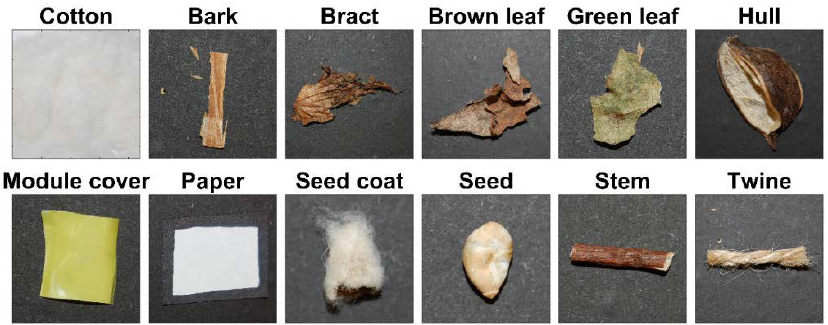
Figure 2. Color photographs of foreign matter and cotton lint samples representative of the classes used in this study.